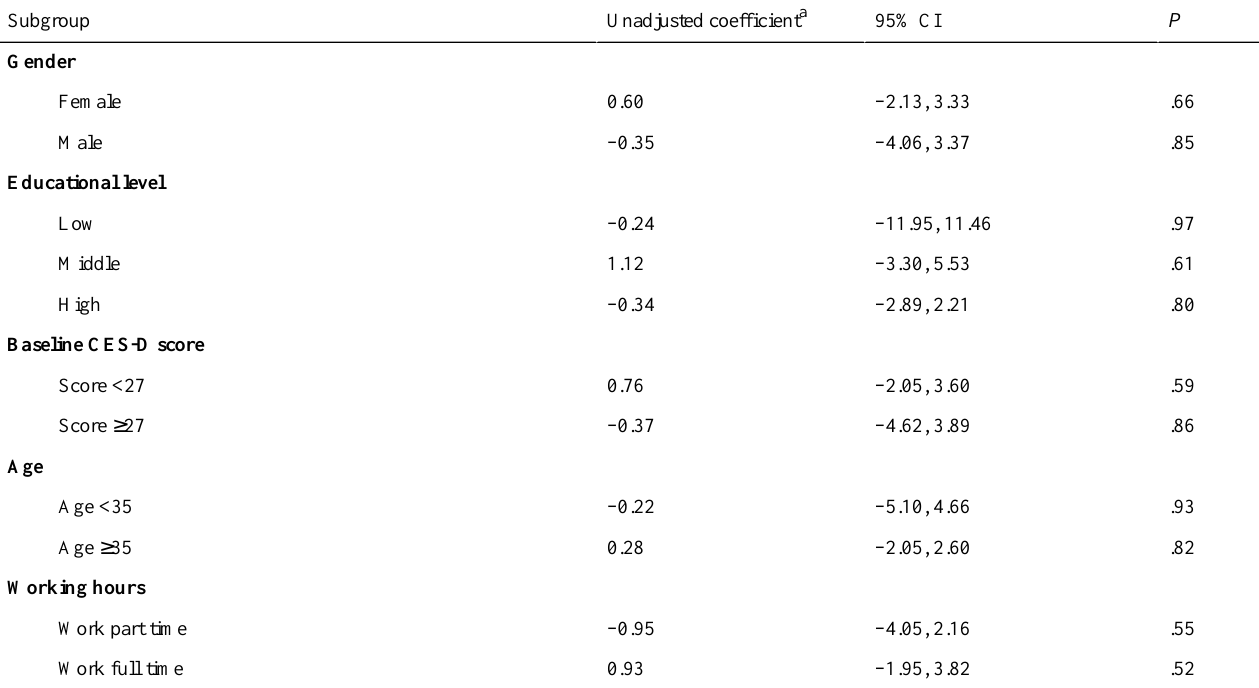
Table 4. Overall effectiveness on depressive symptoms in different